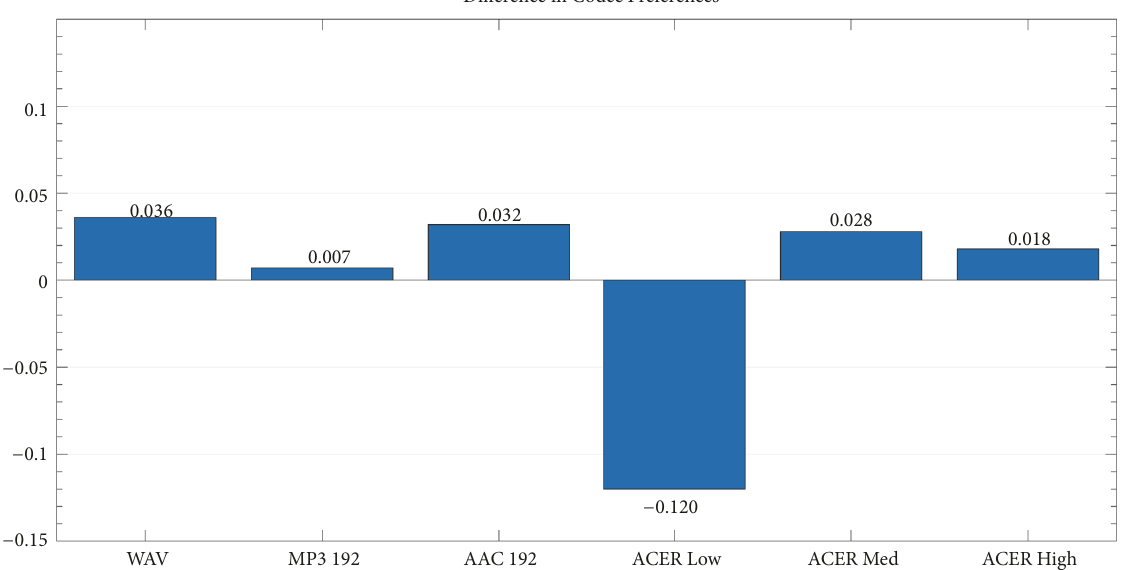
Figure 6: Difference between favourite and least favourite